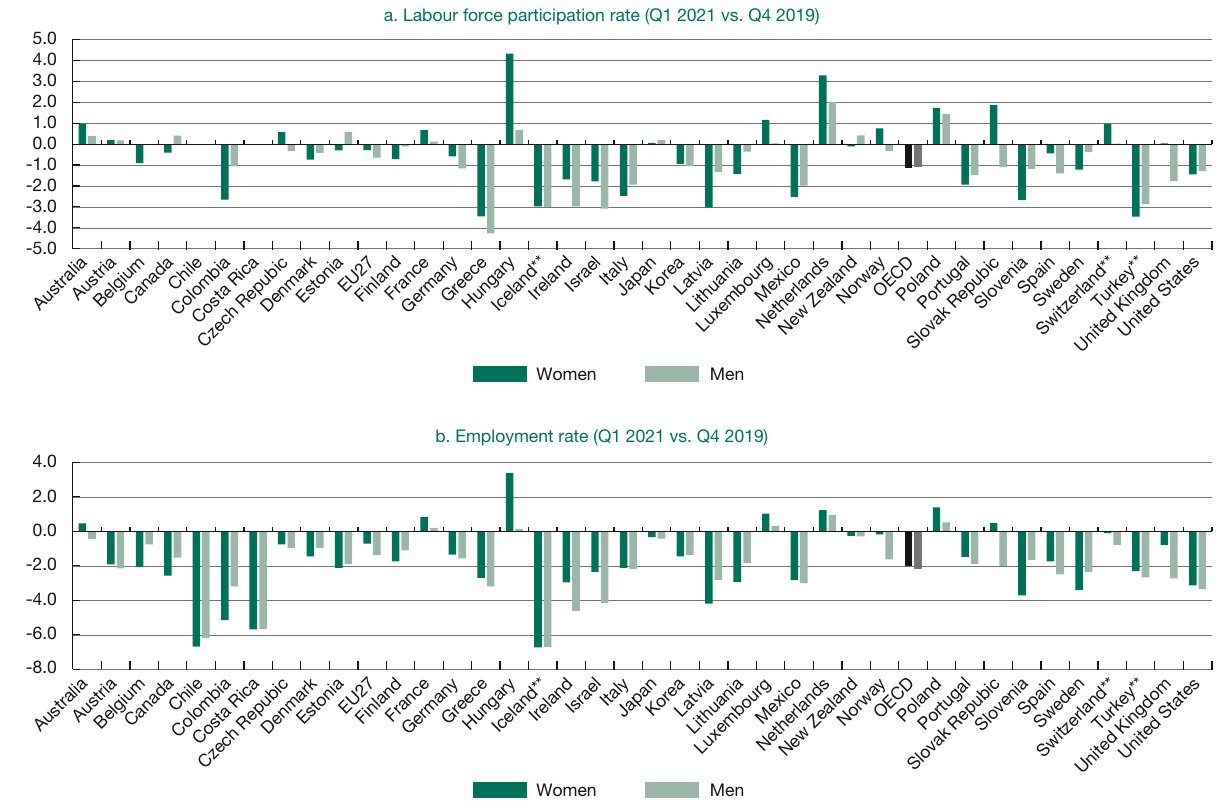
Changes in labour force participation, employment rate and unemployment rate since the onset of the COVID-19